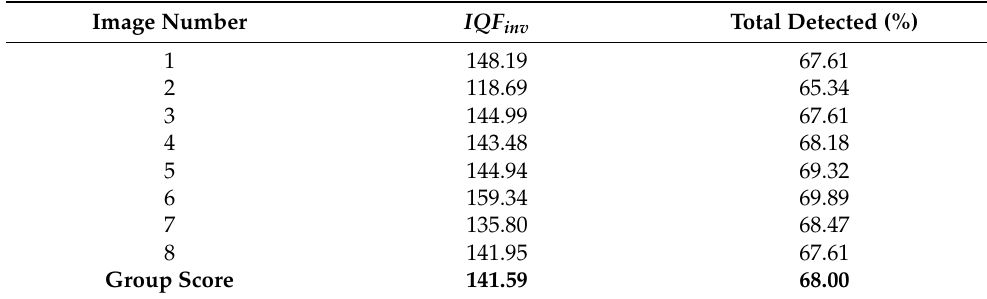
Table 1. Example of the output of the CDMAM3.4 Analyser software: IQFinv and Total detected scores for each image and the average of whole images (Group